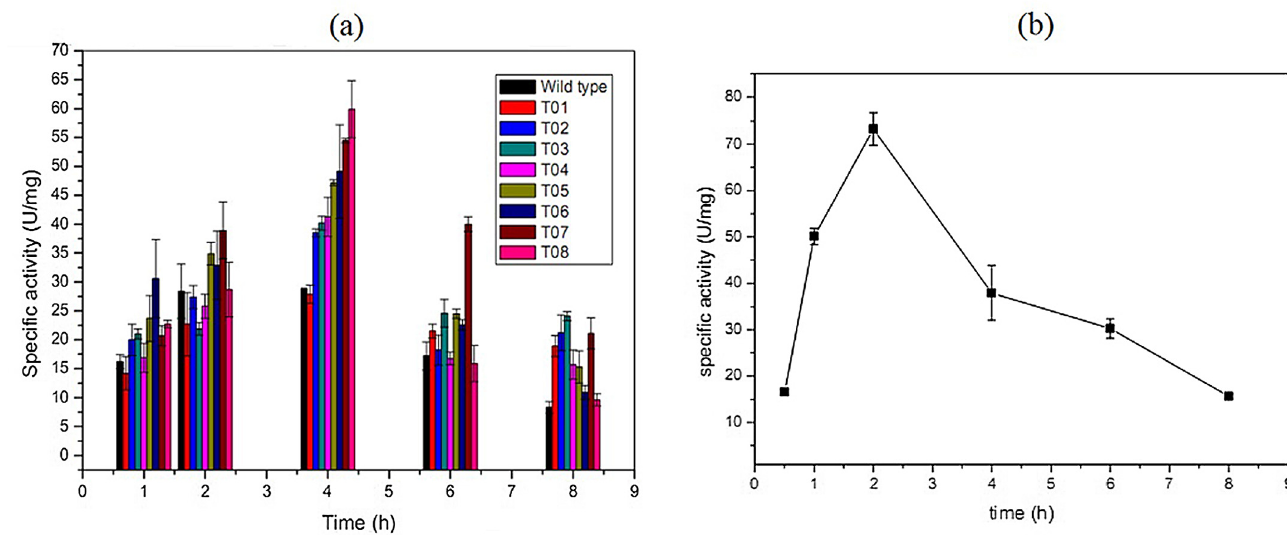
Fig 5. Optimal induce time of the T01-08, opt- nox and the wild type. (a)Comparison of the specific activity of the T01-08 and the wild type with different induced time (1 – 8h). (b) Optimal inducing time of the opt- nox .